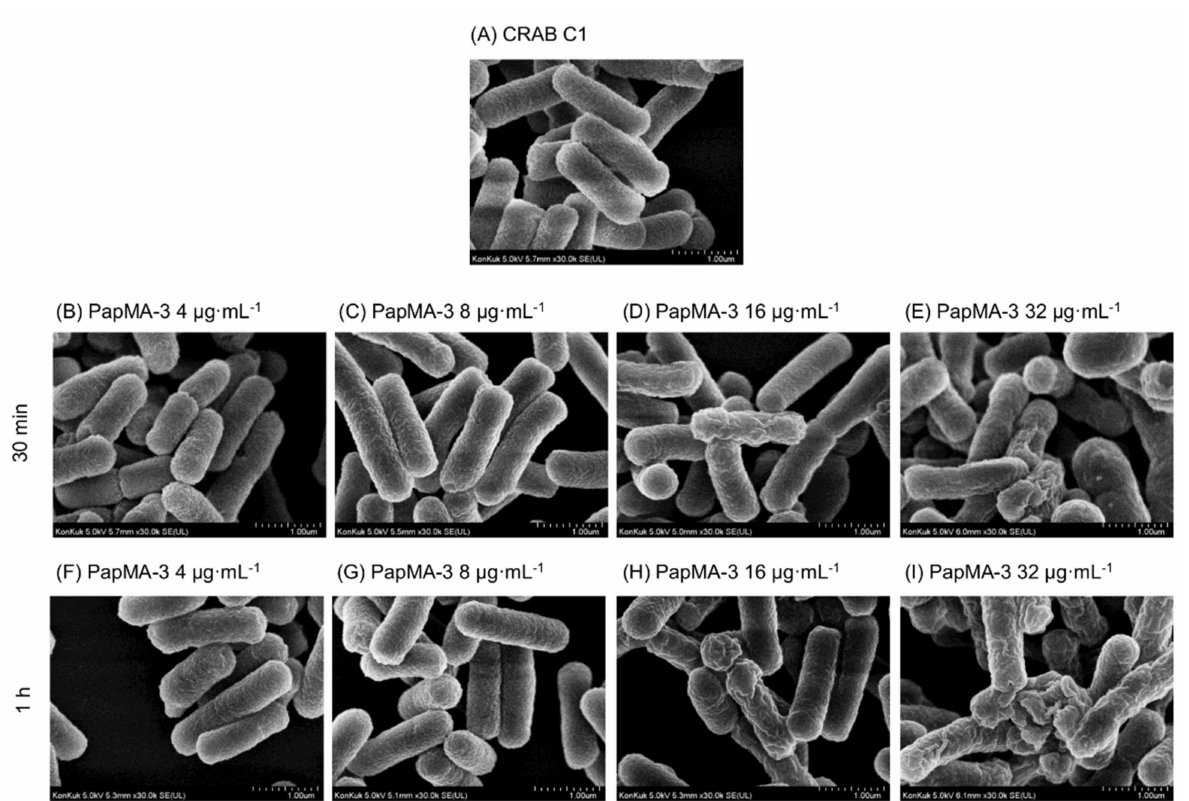
Figure 7. FE-SEM images of CRAB C1 treated with PapMA-3. ( A ) Only CRAB C1. ( B – E ) after incubation for 30 min with PapMA-3 at 4 (1/4 MIC), 8 (1/2 MIC), 16 (1 MIC), and 32 µ g · mL − 1 (2 MIC), respectively. ( F – I ) same experiments after incubation for 1 h,